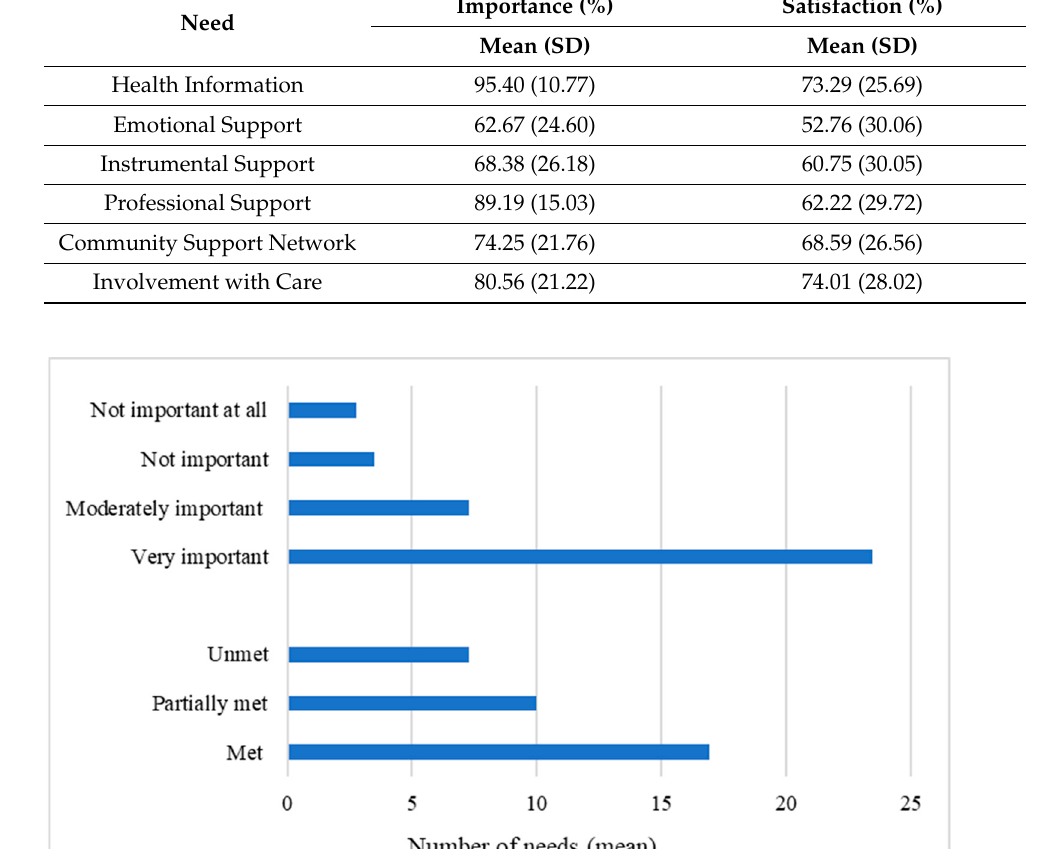
Figure 1. Number of needs according to their importance and satisfaction.